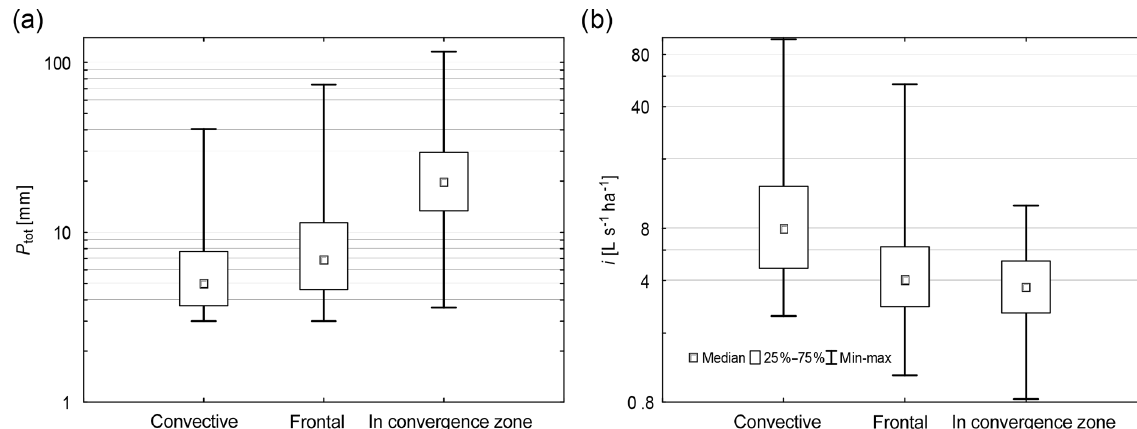
Figure 2. Positional statistics of rainfall depth (a) and rainfall intensity (b) in genetic